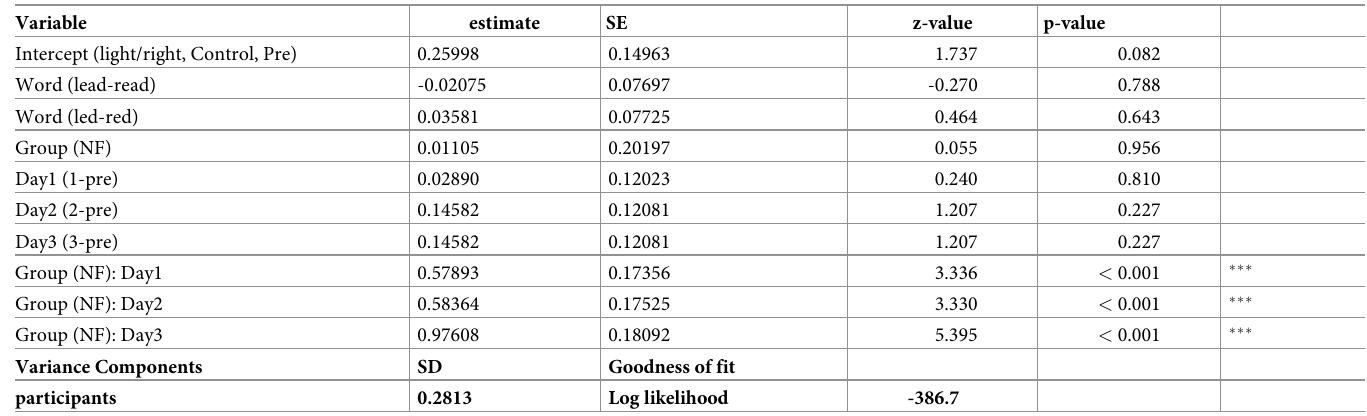
Table 1. Proportion of correct responses in the discrimination task.